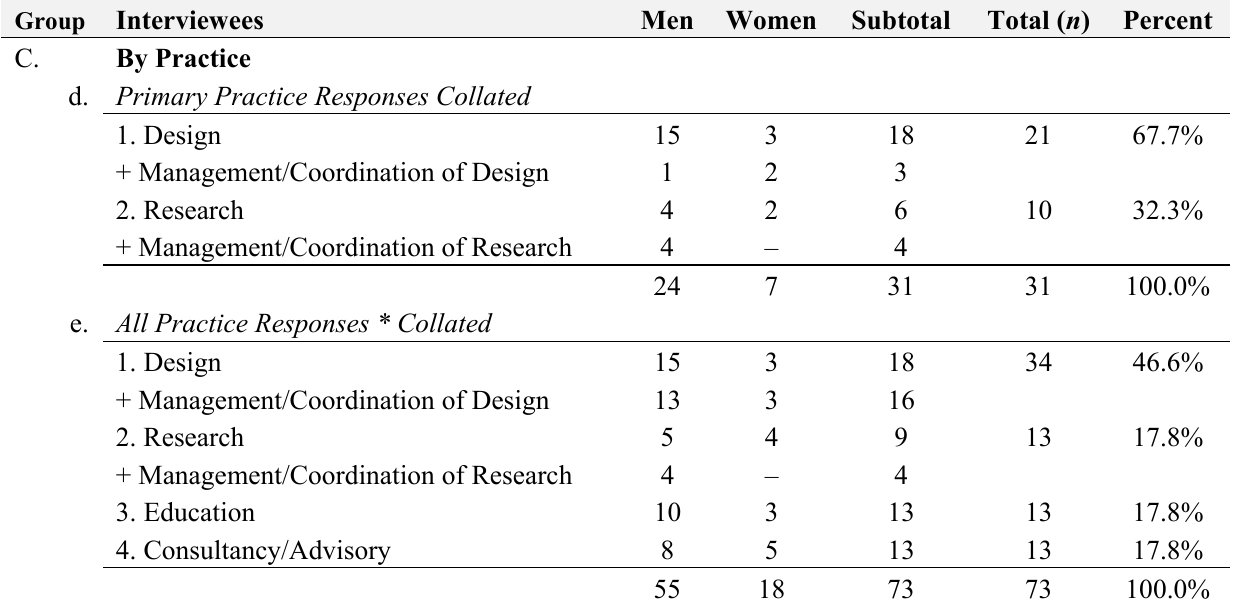
Table 3. Collated responses of interviewees by practice.